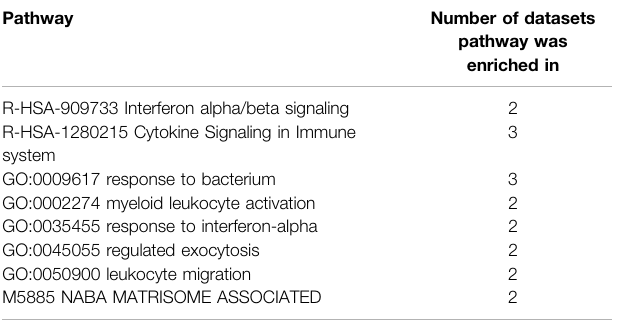
TABLE 11 | List of COVID-19 pathways common between multiple datasets. pathway was